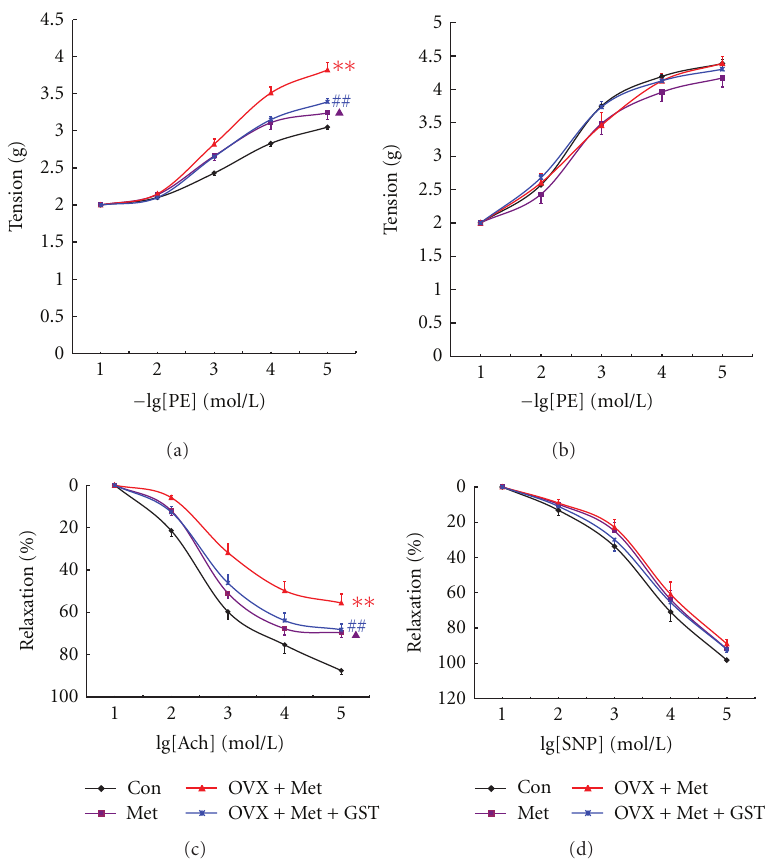
Figure 2: E ff ect of genistein on vascular function in ovariectomized HHcy rats. (a) Response to PE of endothelium-intact thoracic aorta rings. 2.5% Met diet for 12wk induced an enhanced contraction in response to PE, and ovariectomy aggravated this contraction. Supplementation with genistein for 12wk could significantly attenuate the contraction in ovariectomized HHcy rats. ## P < 0 . 01 versus Con; ∗∗ P < 0 . 01 versus Met, (cid:2) P < 0 . 05 versus OVX + Met; (b) Response to PE of endothelium-denuded thoracic aortas rings. There was no significant di ff erence in PE-elicited contraction among groups ( P > 0 . 05). (c) Response to ACh of endothelium-intact thoracic aorta rings. HHcy induced a significant decrease in relaxation to ACh, and ovariectomy further decrease this e ff ect. Supplementation with genistein for 12wk could significantly improve the relaxation to ACh in ovariectomized HHcy rats. ## P < 0 . 05 versus Con; ∗∗ P < 0 . 05 versus Met, (cid:2) P < 0 . 05 versus OVX + Met; (d) Response to SNP of endothelium-denuded thoracic aortas rings. There was no significant di ff erence in response to SNP among groups ( P > 0 . 05). All the results were analyzed by one-way ANOVA ( n = 6 ∼